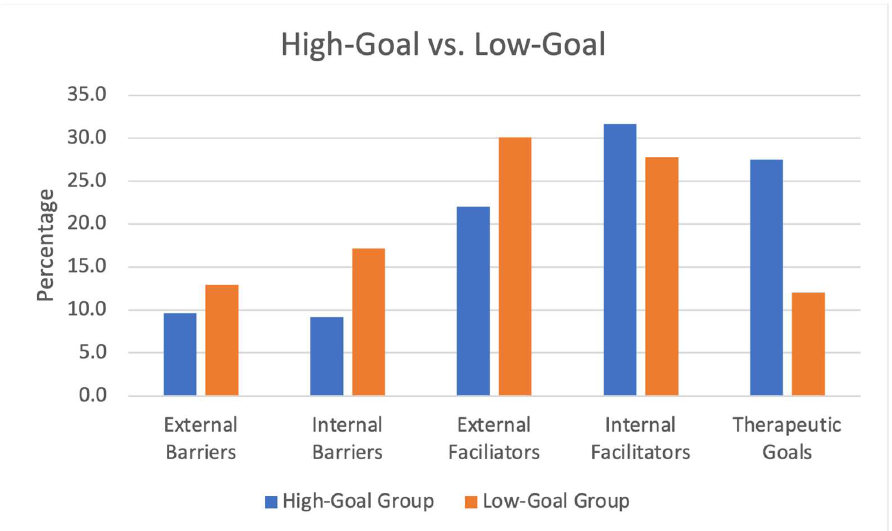
Figure 3. Relative distribution of external barriers, internal barriers, external facilitators, internal facilitators and psychotherapy goals for each case according to type. The high-goal type group consists of participants whose goals are >20% in relation to the other four items. The low-goal type group consists of participants whose goals are > 20% in relation to the other four items.